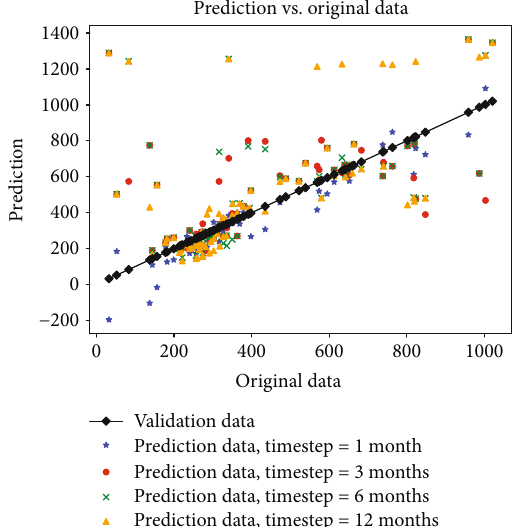
Figure 5: Cross-plot of prediction and oil rate data in Bakken formation.